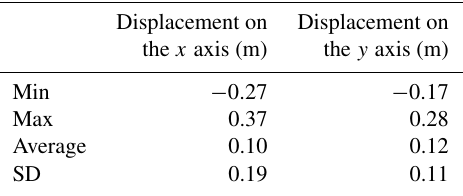
Table 1. Summary of coordinate differences between GPS/Beidou and MTi-IMU results (outdoor environment).